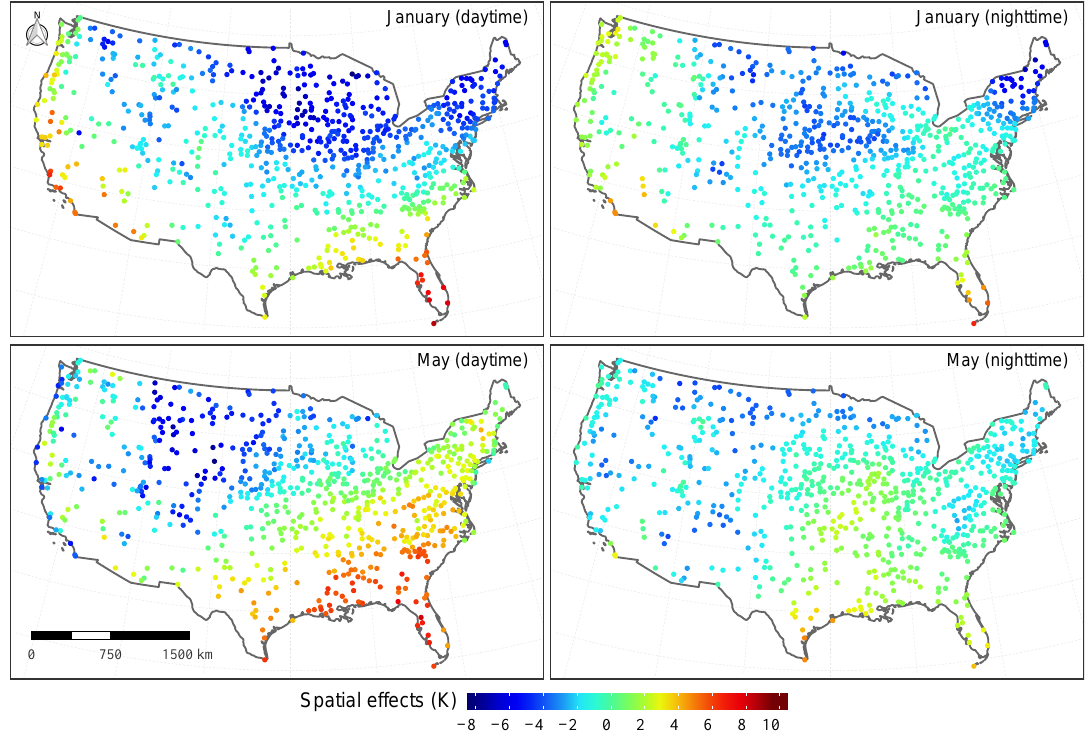
Figure 9. Spatial distributions of fitted spatial random effects in the fitted BKR models ( top left : the daytime model in